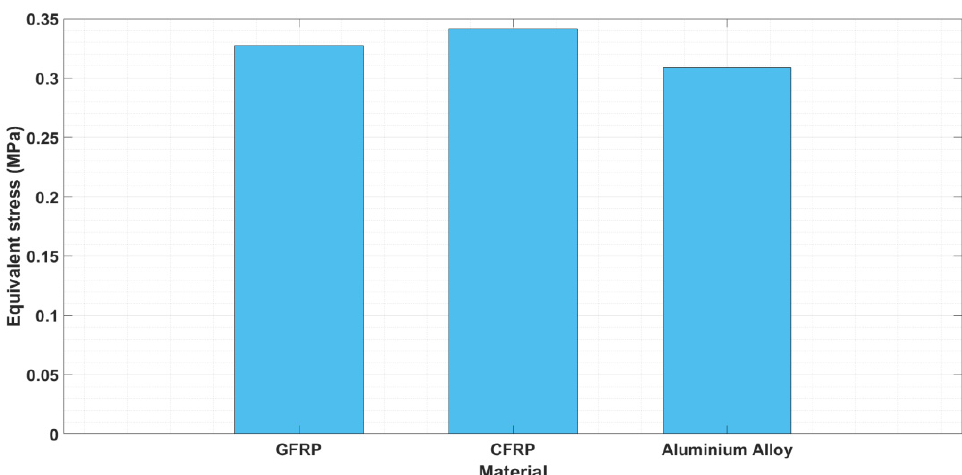
Figure 35. Variations of normal stress on the octocopter.